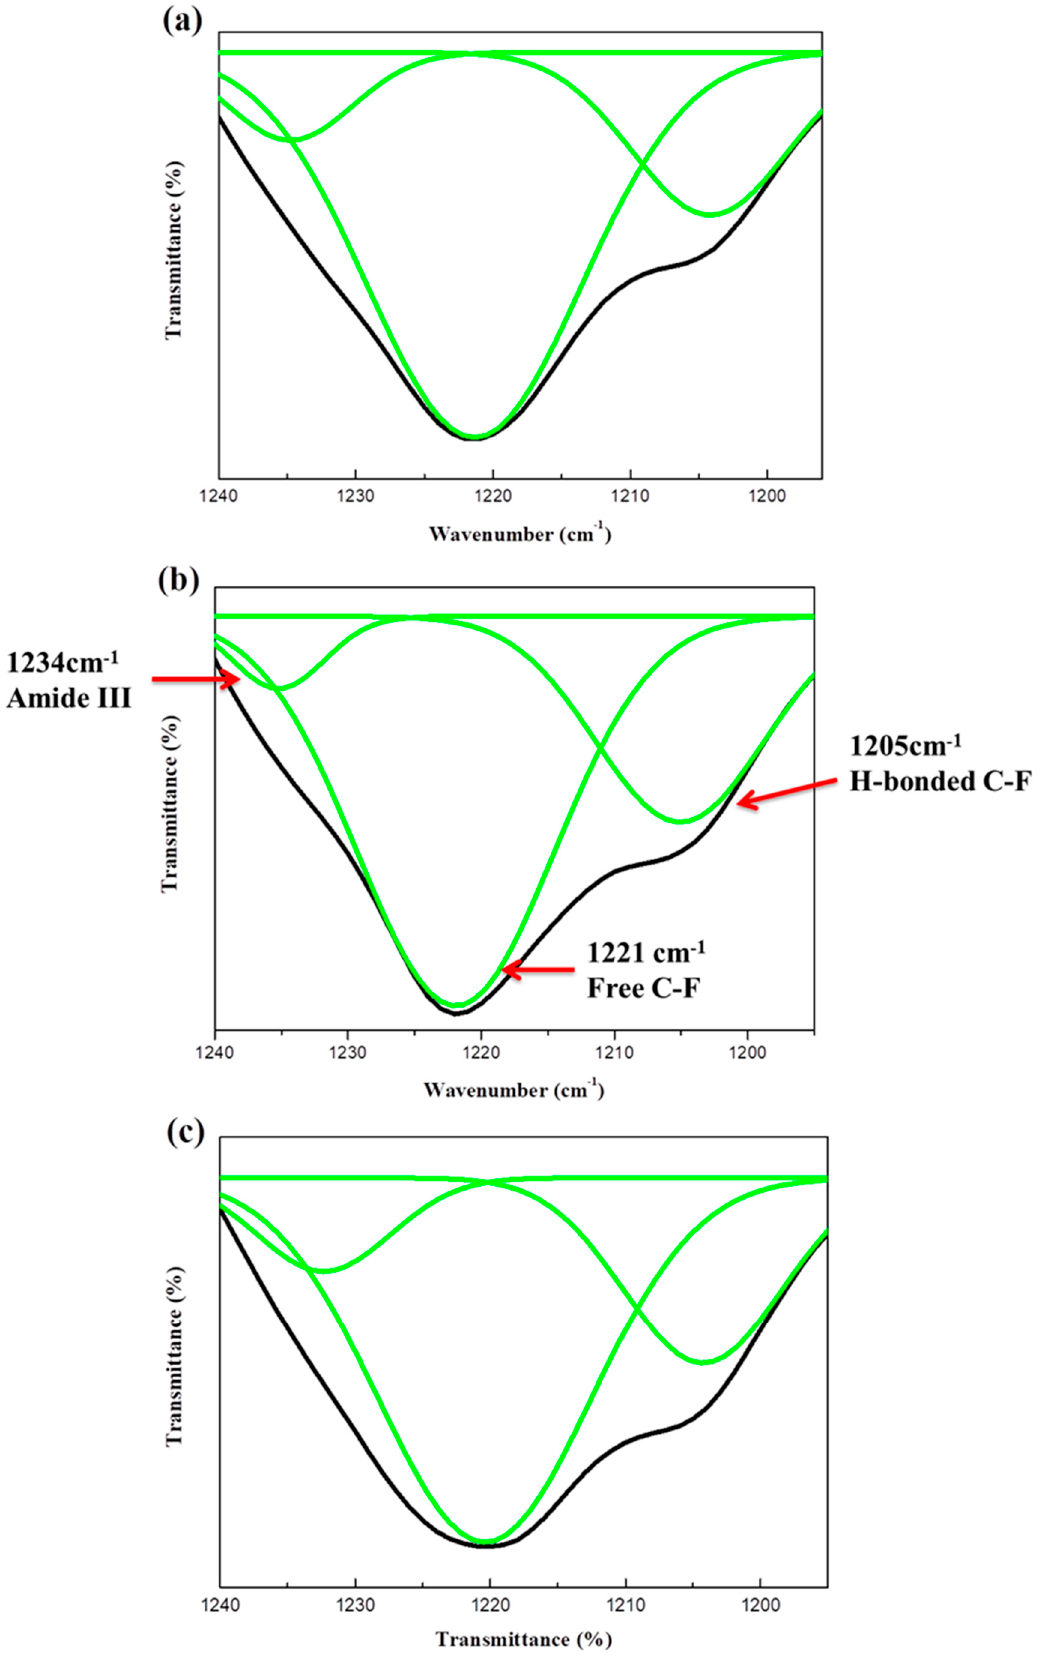
Figure 3. FT-IR spectra of ( a ) PFD/PU-01, ( b ) PFD/PU-02, and ( c ) PFD/PU-03 at the wavenumber range of 1240–1190 cm –1 .